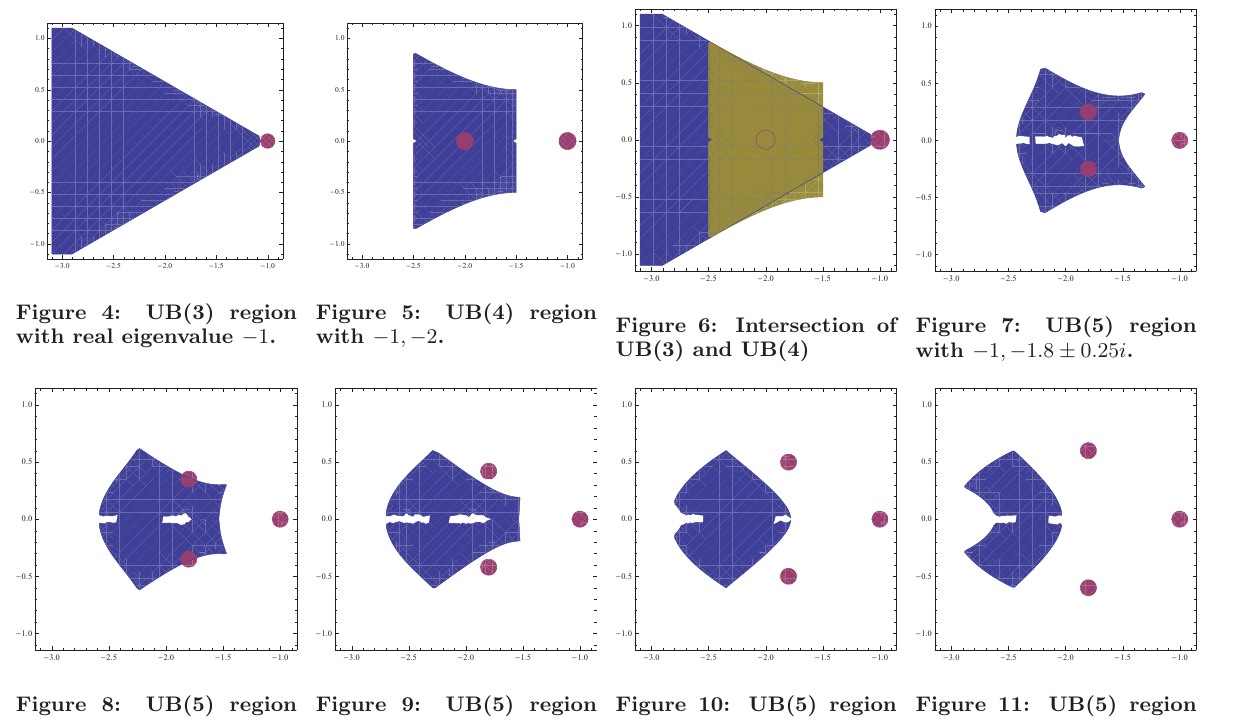
Figure 8: UB(5) region with − 1 , − 1 . 8 ± 0 . 35 i .